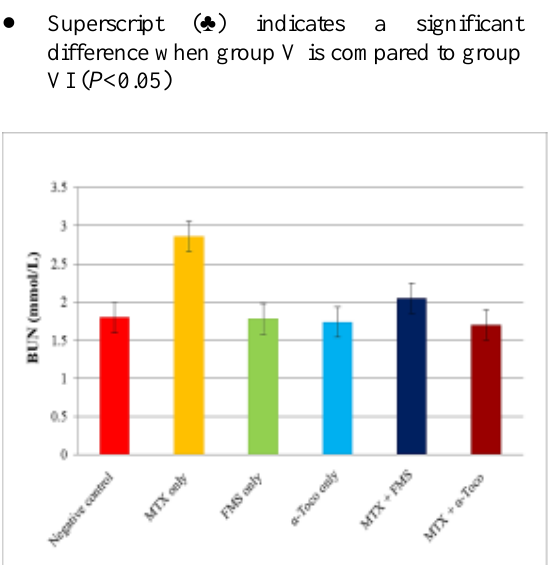
Table 2.Effects of fimasartan on the renal